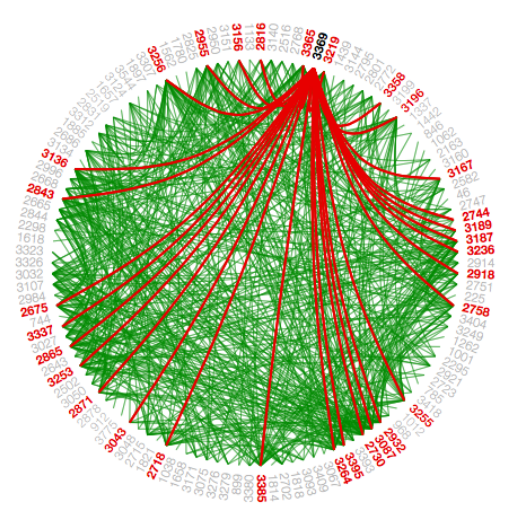
Figure A7. Representation of the Facebook data-set using Hierarchical Edge Bundling Visualization with low tension.